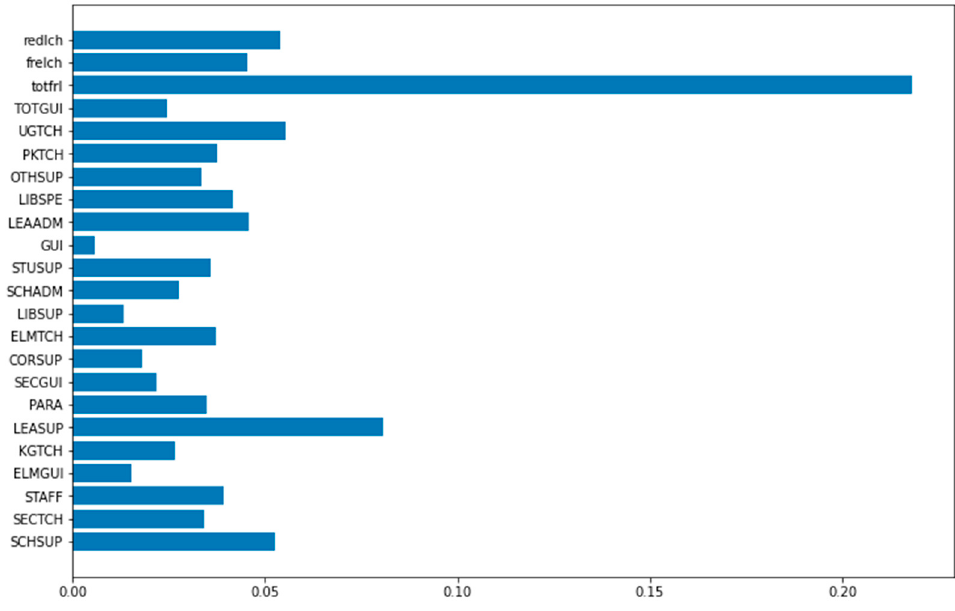
Figure 10. Results of random forest tree regression.